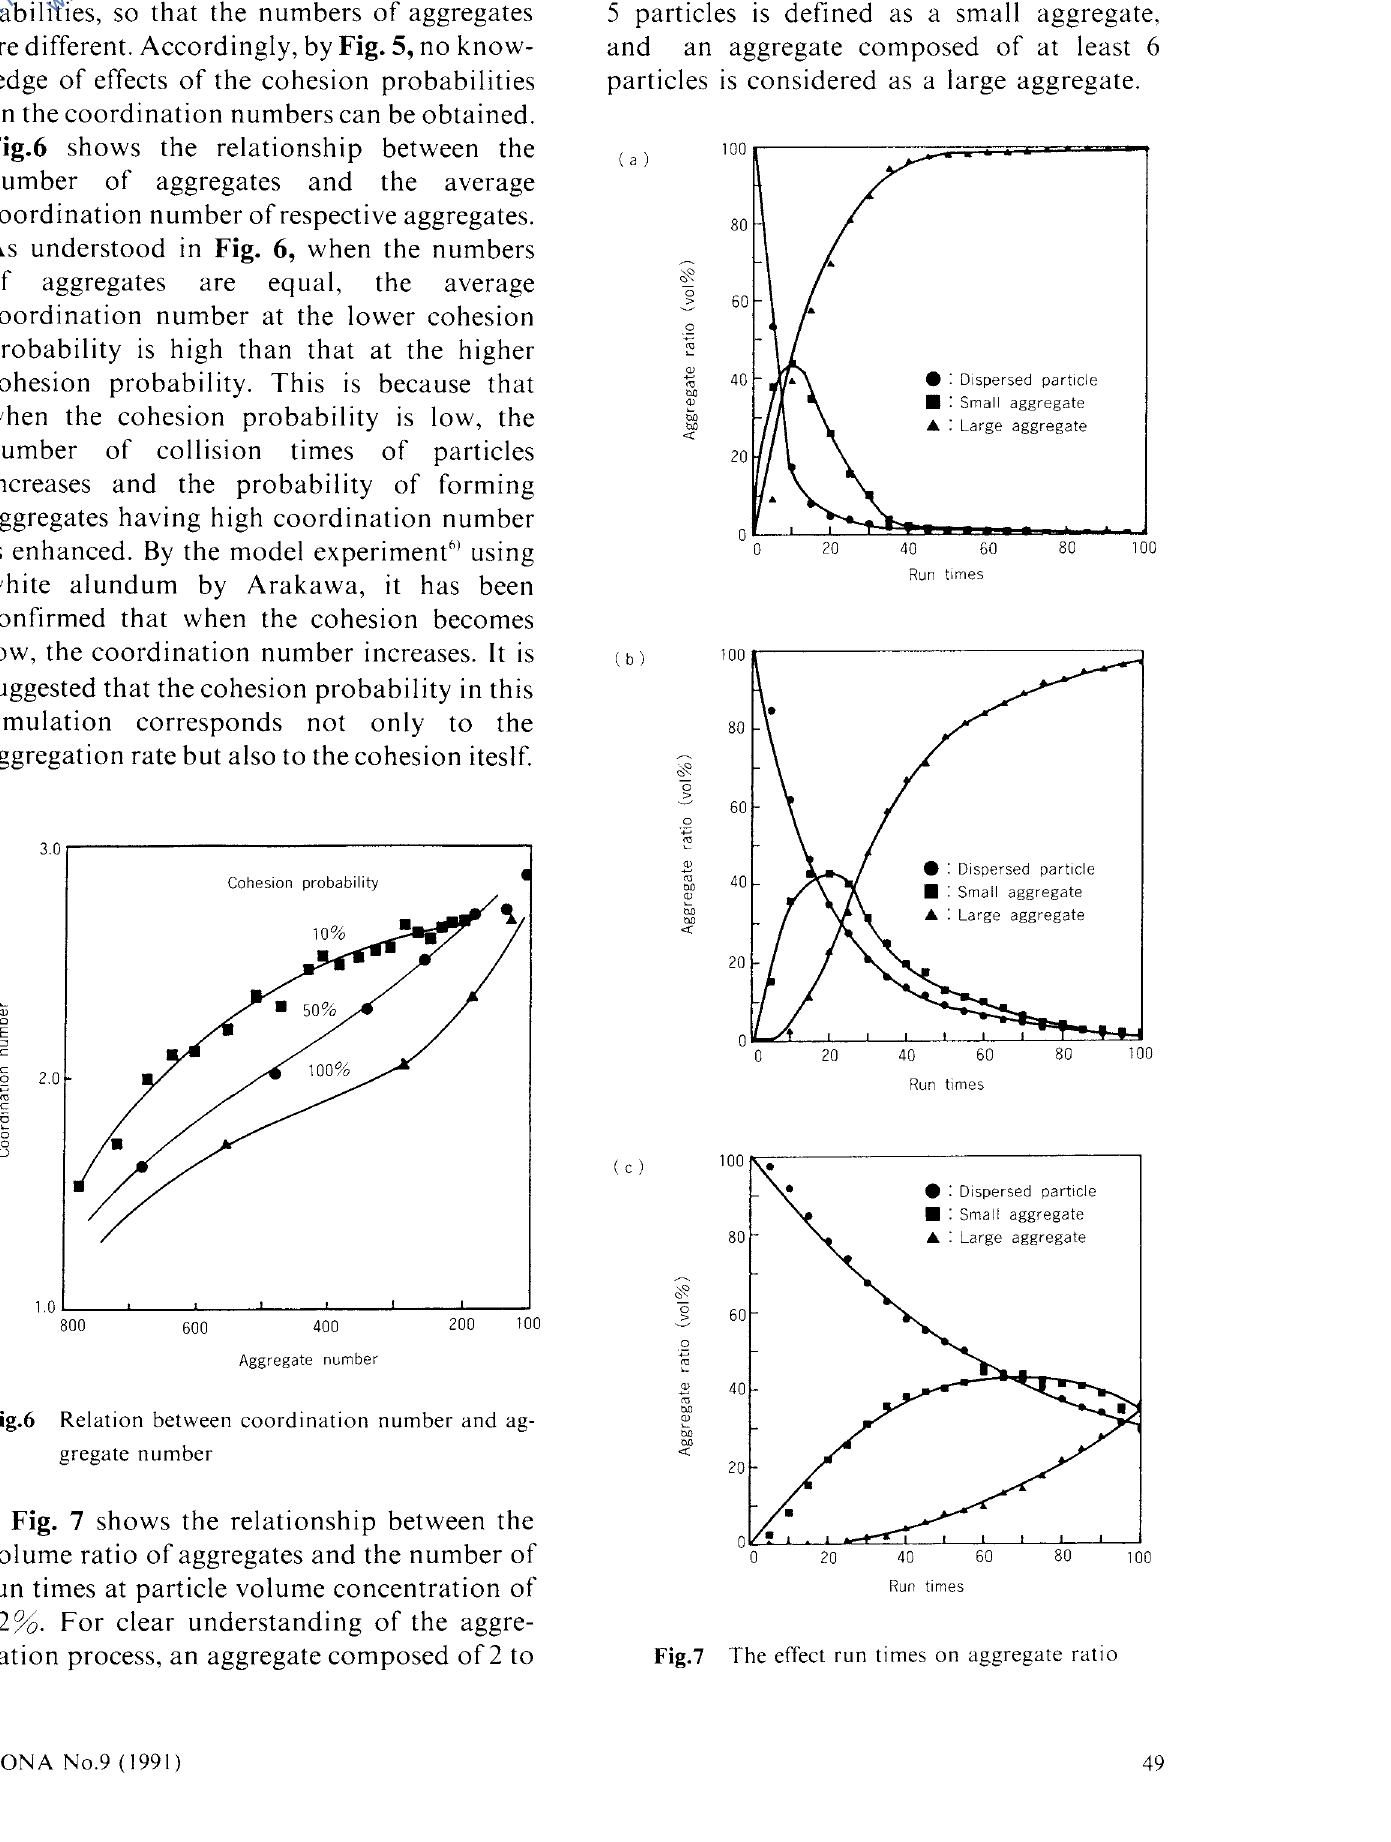
Fig.7 The effect run times on aggregate